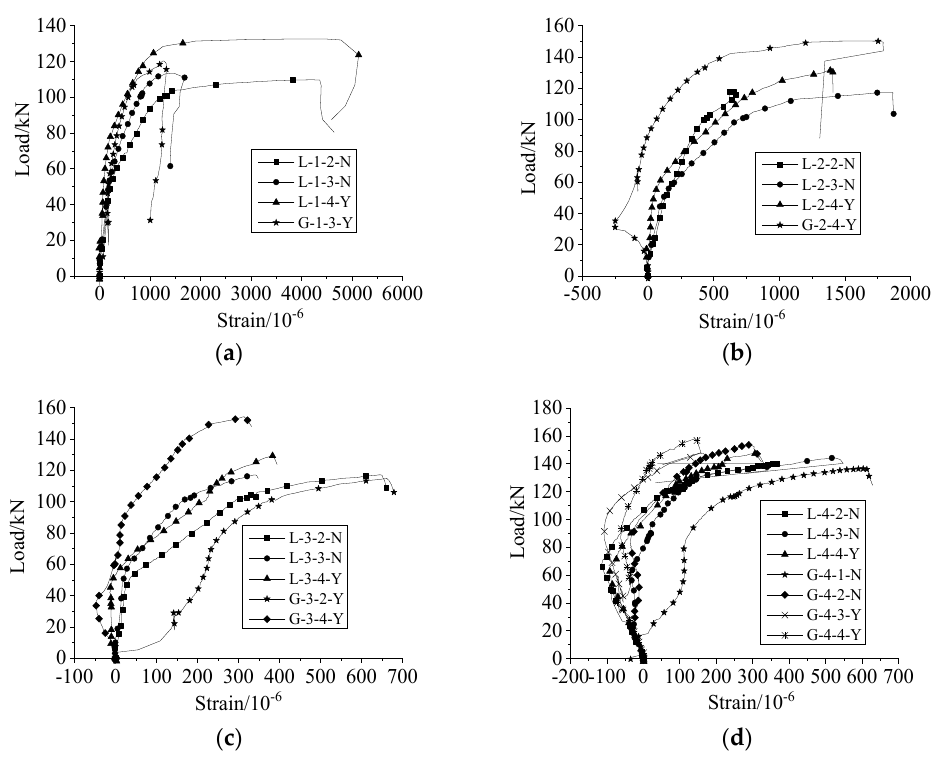
Figure 19. Load–hoop strain curves for the middle section of the sleeve near the steel bar under uniaxial tension and repeated high-stress tension and compression loading (the final tension process) (SH3). ( a ) L = 6 d, ( b ) L = 8 d, ( c ) L = 10 d, ( d ) L = 12.5 d. The influence of the lapping length on the average longitudinal and hoop strains of the middle section of the sleeve is shown in Figure 20. The longitudinal compressive strain and the hoop tensile strain of the middle section of the sleeve were decreased under uniaxial tension and repeated tension and compression (only the final tension process) loading with the increase in the lapping length of steel bars.